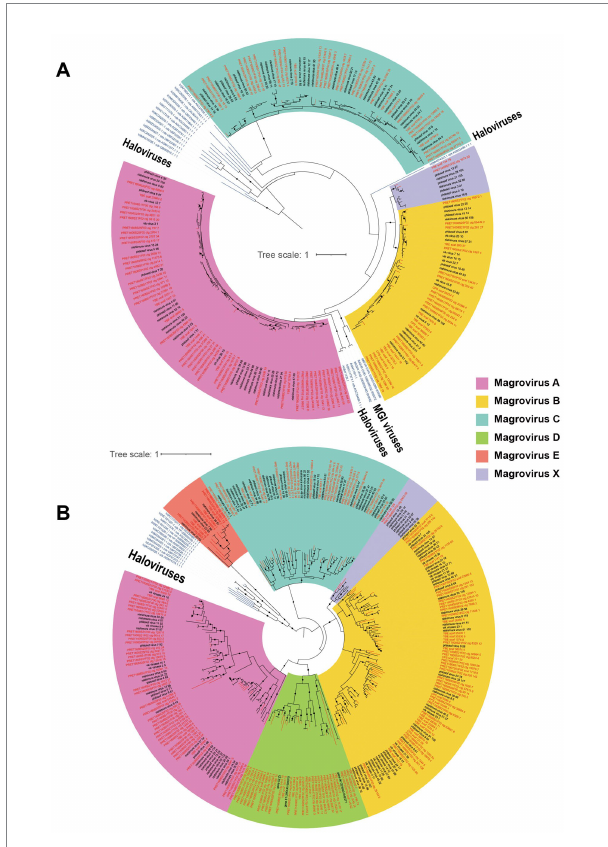
FIGURE 1 Unrooted maximum-likelihood trees of MCP (A) and DNApolB (B) , respectively. The names of brackish magroviruses are in red, the marine references are in black, and the other tailed viruses are in blue. The solid dots on internal branches show branch supports >0.95 (based on 1,000 iterations of bootstrapping). The colored blocks show subgroups of